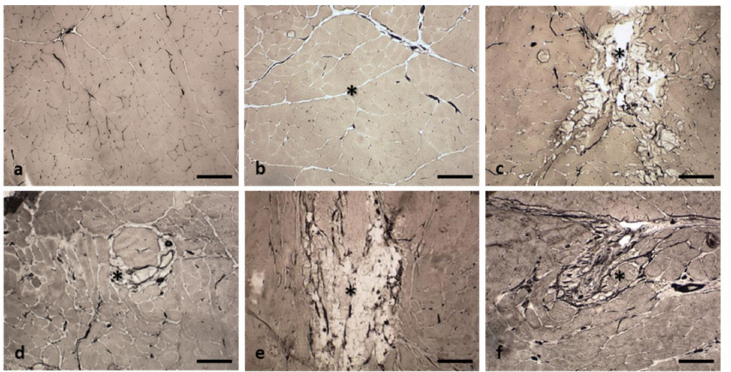
Figure 7. Representative images of the central area of injury in each group. The vascular network is stained black with the ATPase histochemical technique. In the NC group, the vascular network is poorly marked ( a ). In the RC ( b ) and OS ( e ) groups, greater vascularization is observed in the periphery of the regenerated and implantation areas, respectively (asterisks). In the FC ( c ), AT ( d ) and DM ( f ) groups, vascularization is more increased within the implantation zone (asterisks). ATPase pH 4.2. Size scale: 100 µ